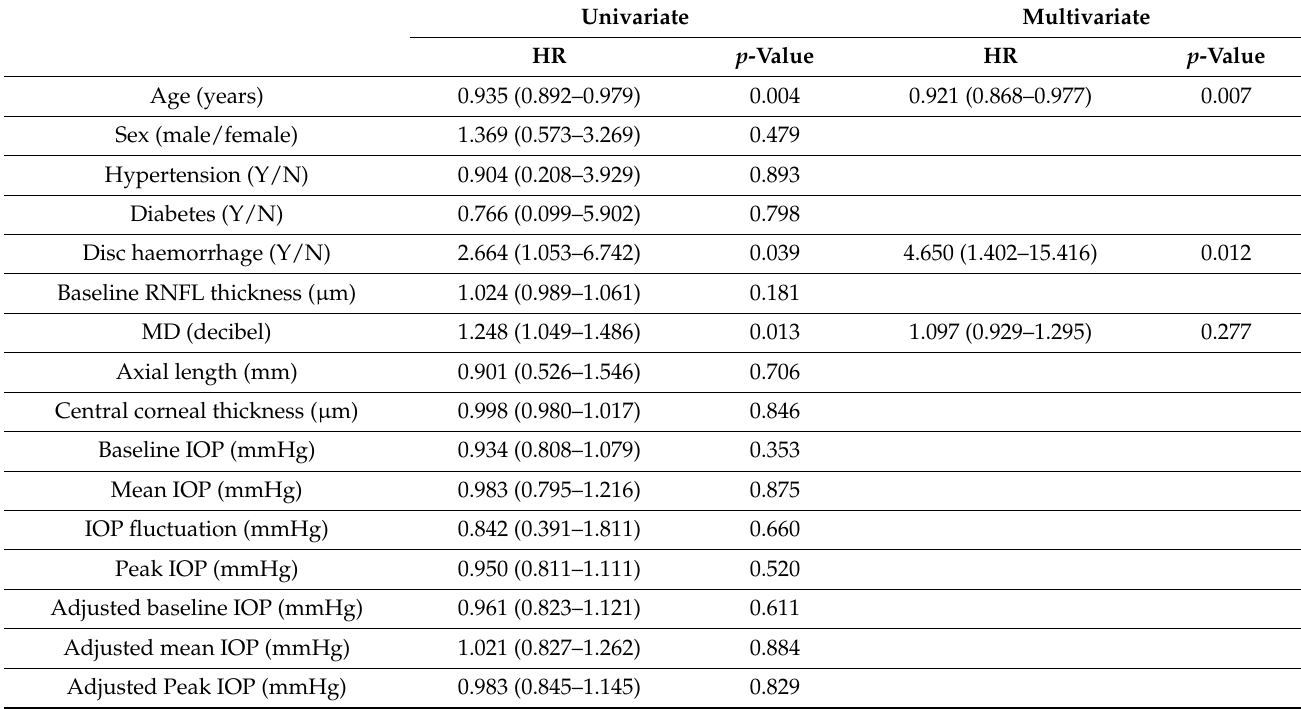
Table 3. Cox regression for the non-LRS